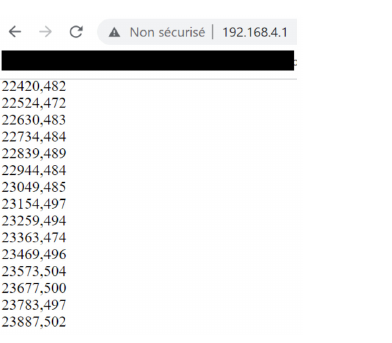
Figure 14. Browser window open on the IP address with printed data.